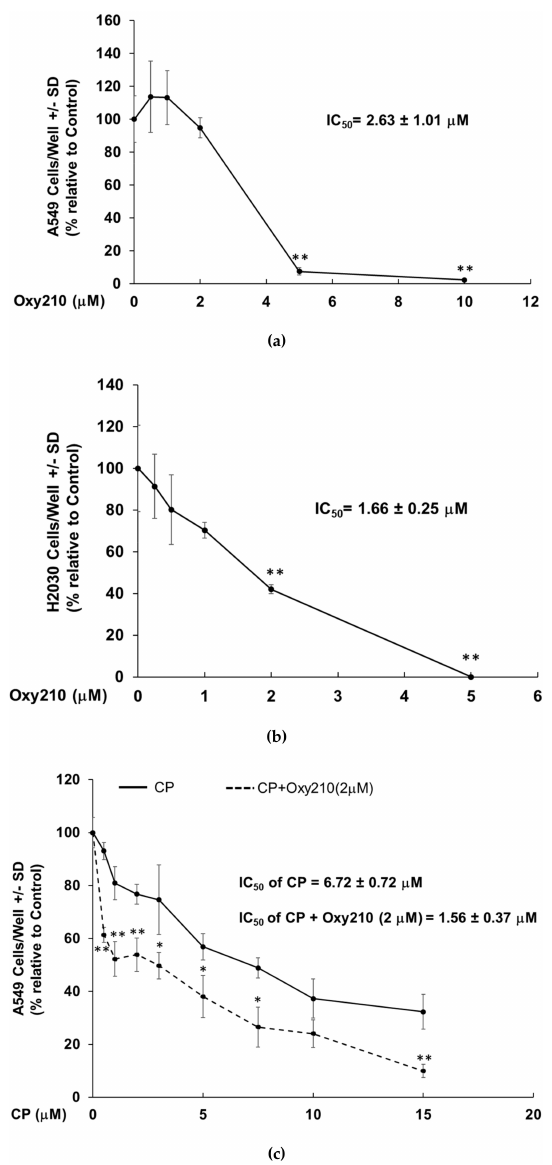
Figure 7. Inhibition of NSCLC cell proliferation by Oxy210. A549 ( a ), ( c ) and H2030 ( b ) cells were treated with the test agents as indicated in RPMI 1640 containing 5% FBS for 5 days and then were trypsinized and counted as described in Methods and Materials section. Data from a representative experiment are reported as the mean of triplicate determinations ± SD (* p < 0.05 vs. control; ** p < 0.01 vs. control).